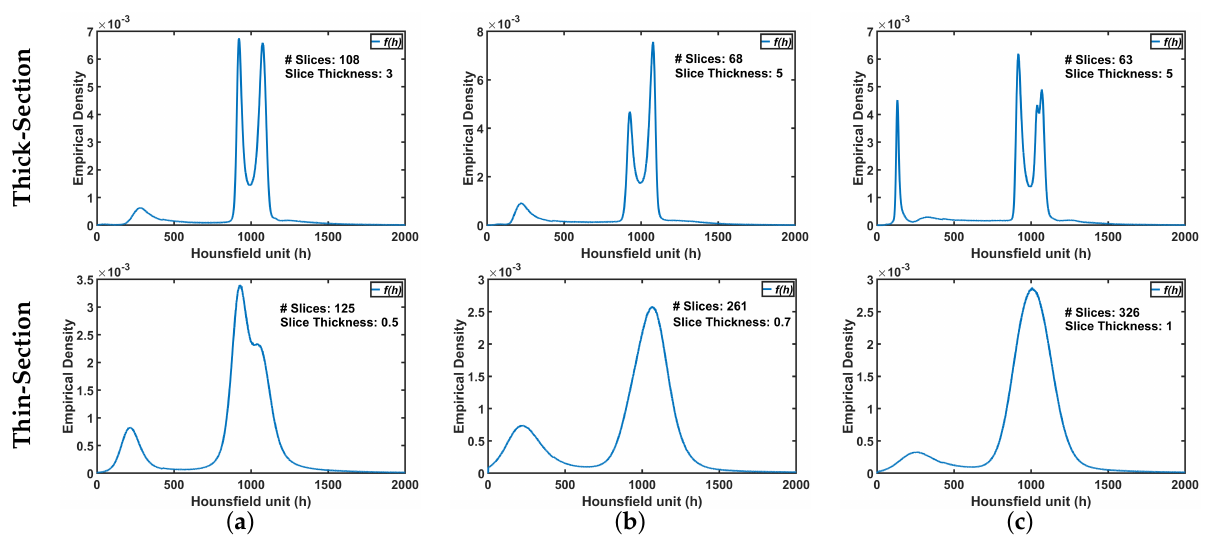
Figure 2. An illustrative example of variability of CT appearance (distribution of radiodensities) for ( a ) healthy/mild, ( b ) moderate, and ( c ) severe COVID-19